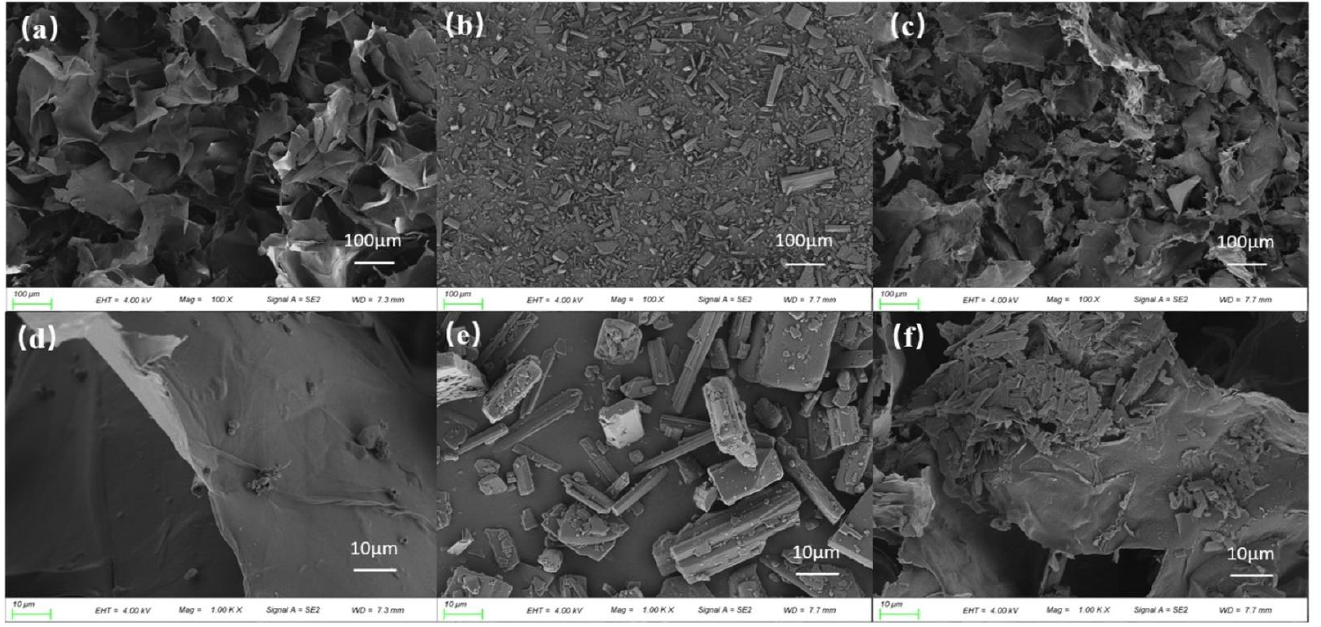
Figure 1. The SEM images of materials and drugs: ( a , d ) The SEM images of TC aerogel. ( b , e ) The SEM images of Res. ( c , f ) The SEM images of RLTA.